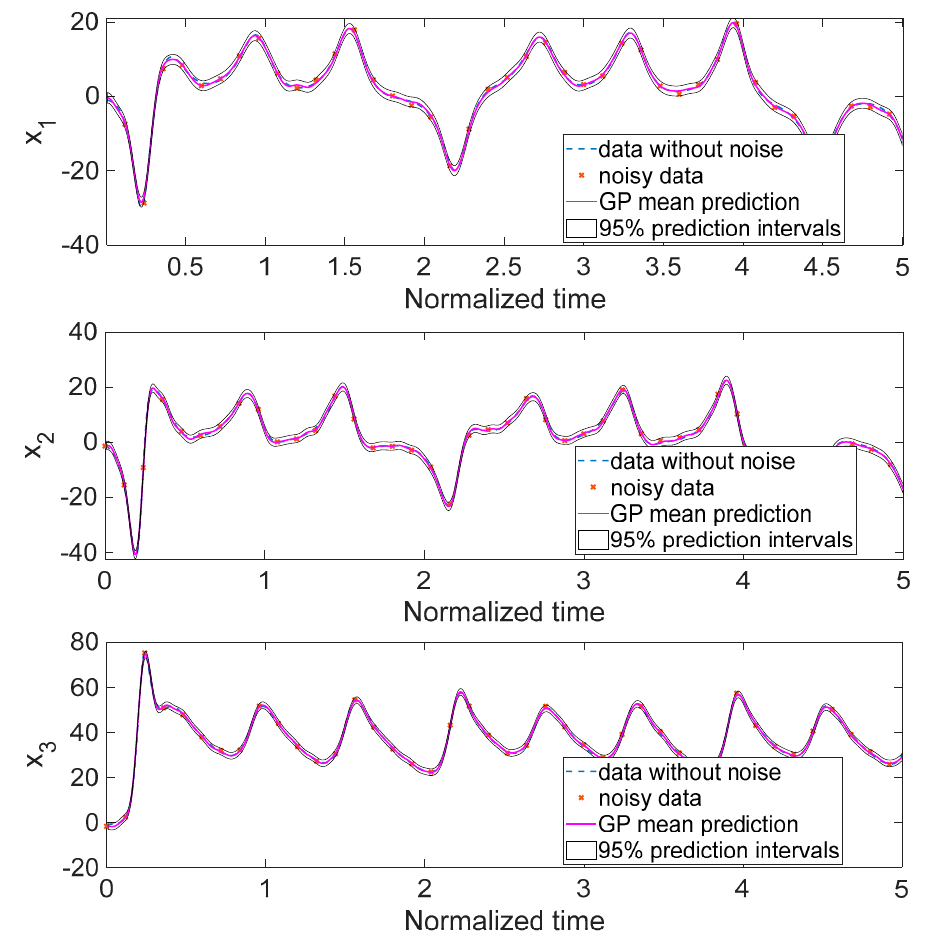
Figure 11. The results of interpolation of chaotic fractional three-echelon supply chain system using GP regressio n.